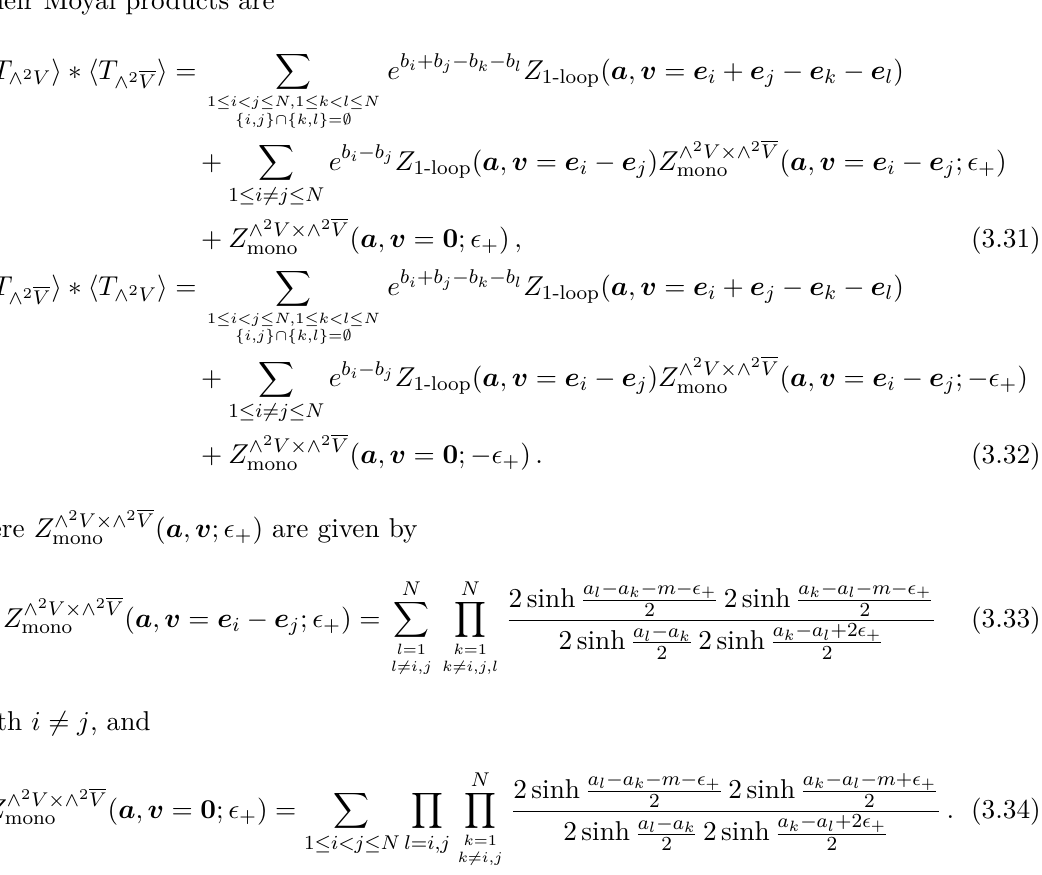
(cid:10) (cid:10) (cid:11) (cid:11) i ∗ T or T ∗ h T i . (b) The quiver diagram describing the ∧ 2 V ∧ 2 V ∧ 2 V ∧ 2 V (cid:10) (cid:11) i ∗ h T i or T ∗ h T i ∧ 2 V ∧ 2 V ∧ 2 V ∧ 2 V